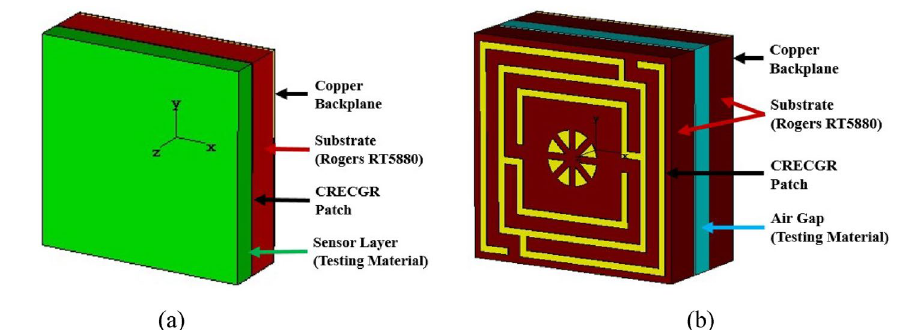
Figure 24. ( a ) Model for sensing solid materials and (b) Liquid (Edible oil) sensing model. (CST STUDIO SUITE 2019, https:// www. 3ds. com/ produ cts- servi ces/ simul ia/ produ cts/ cst- studio- suite) 39